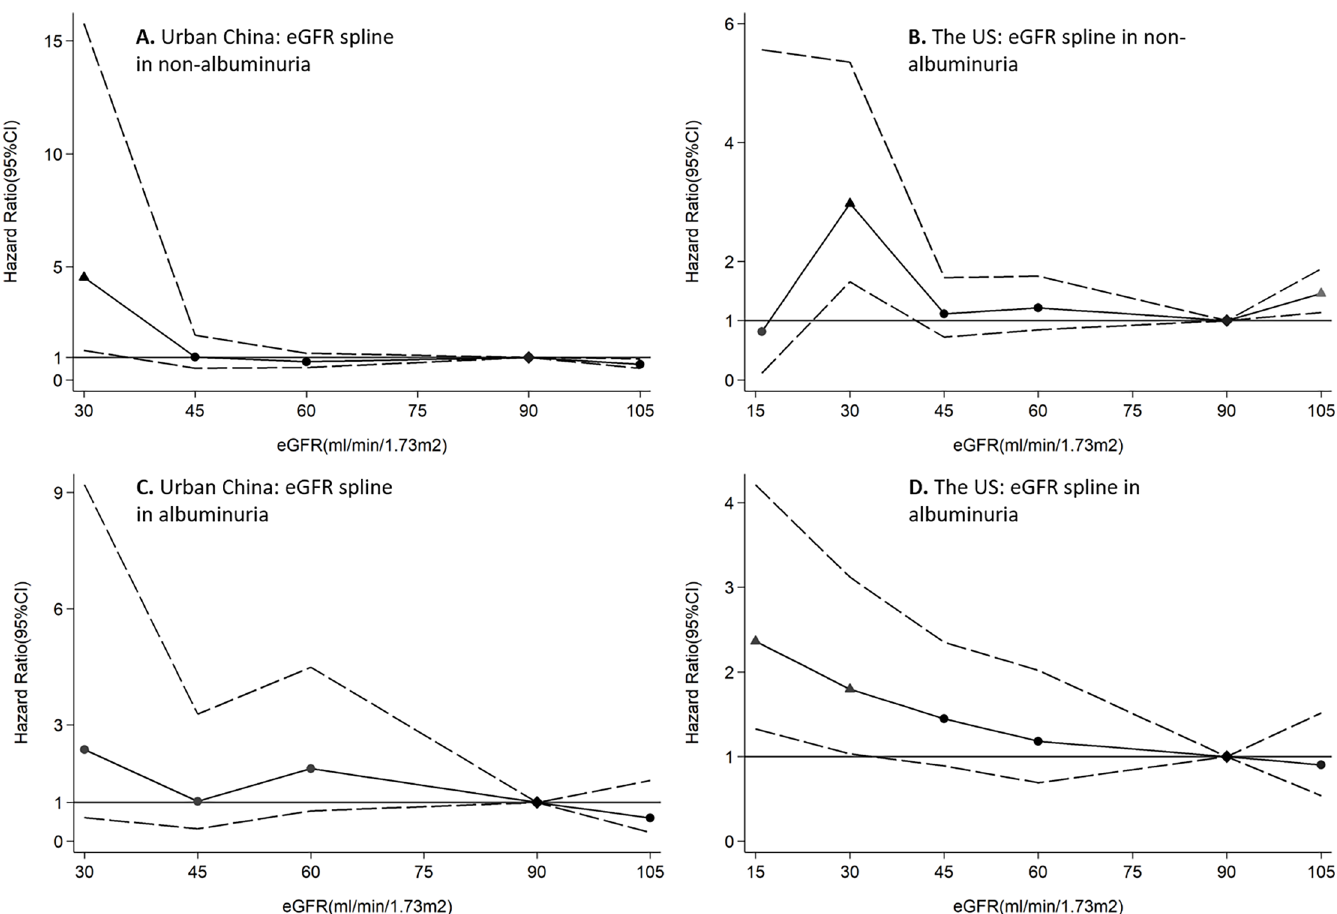
Fig 2. HRs and 95% CIs for all-cause mortality according to spline eGFR stratified by presence of albuminuria in urban China and the US. HRs and 95% CIs (area between dashed lines) according to eGFR in China (A, C) and US (B, D). The associations were adjusted for age, sex, education level, smoking, history of cardiovascular disease, hypertension, diabetes, body mass index, and ln(ACR). The reference (diamond) was eGFR 90 mL/min/1 (cid:1) 73 m 2 . Triangles represent statistically significant and circles represent not significant. Abbreviation: HR = Hazard ratio, CI = Confidence interval, eGFR = Estimated glomerular filtration rate, ACR = Albumin-to-creatinine